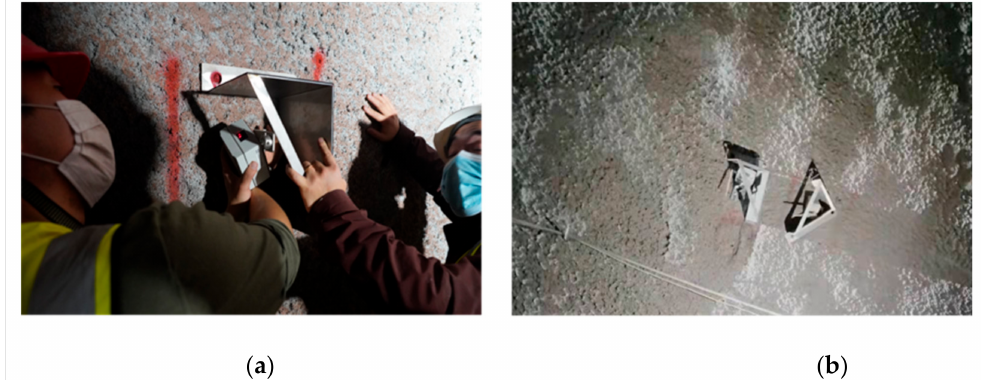
Figure 3. Site photos on the deployment of the sensors and the protective cover: ( a ) cover installation; ( b ) cover and sensors after